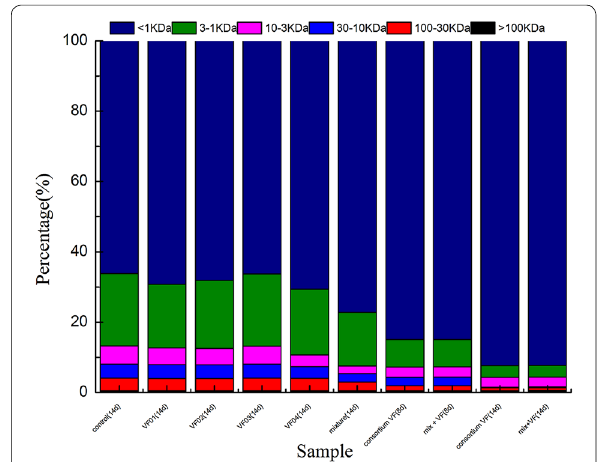
Fig. 6 The molecular weight distribution and proportion of DOM in sewage biodegraded by different combinations of microorganisms for different days [ mix VF mixture with the consortium (VF)] +